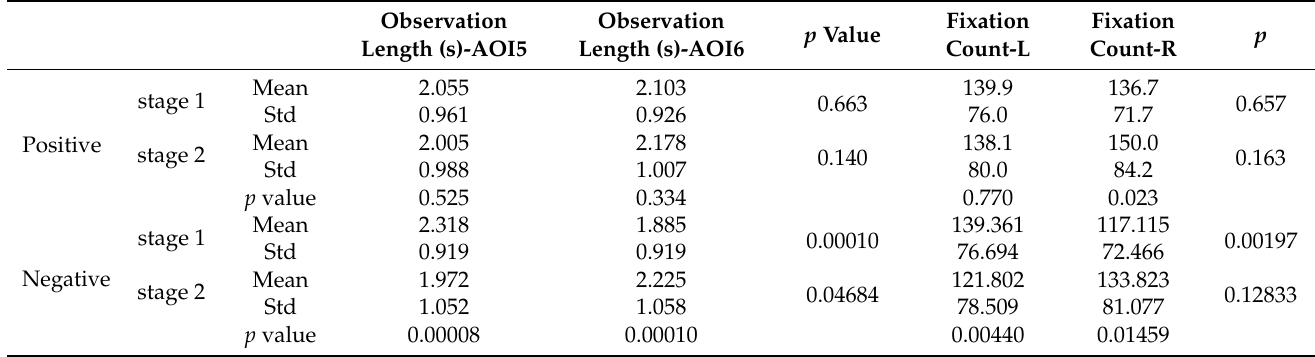
Table 5. Eye tracker result of IAPS stimulation and left–right position factors.